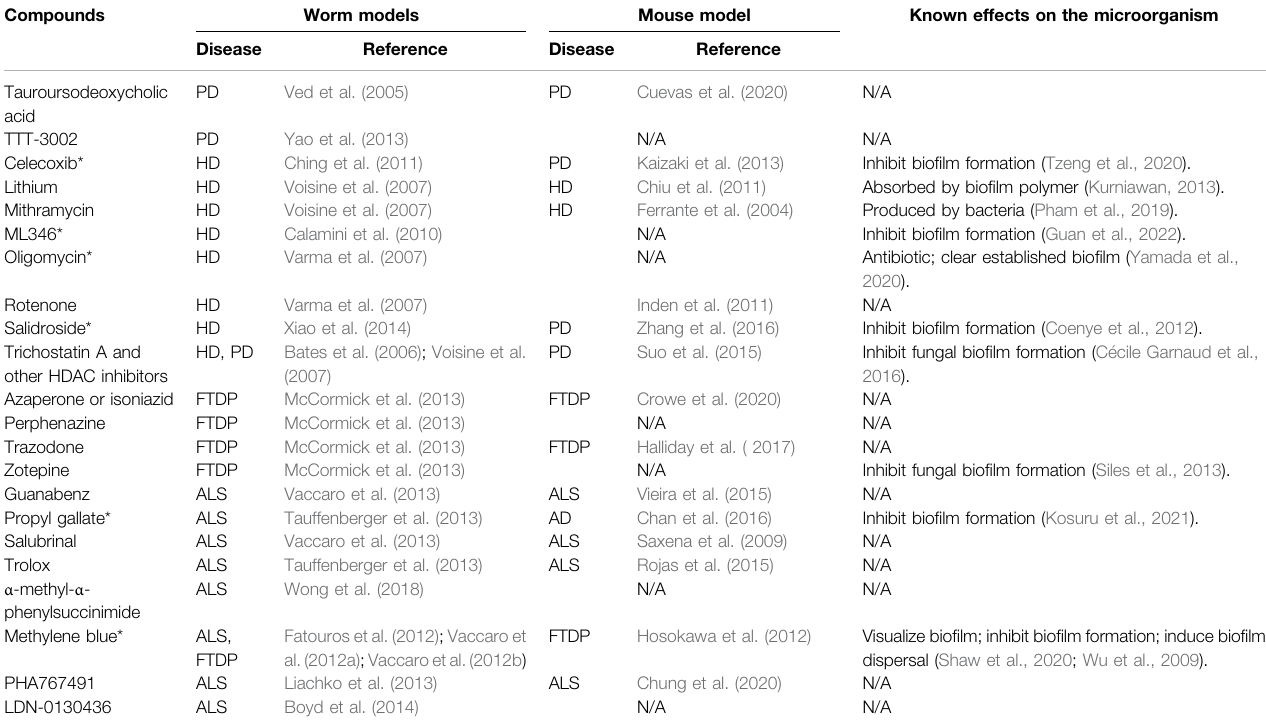
TABLE 1 | ( Continued ) Neuroprotective compounds identi fi ed in C. elegans neurodegenerative disease models and con fi rmed in mouse models showed effects on